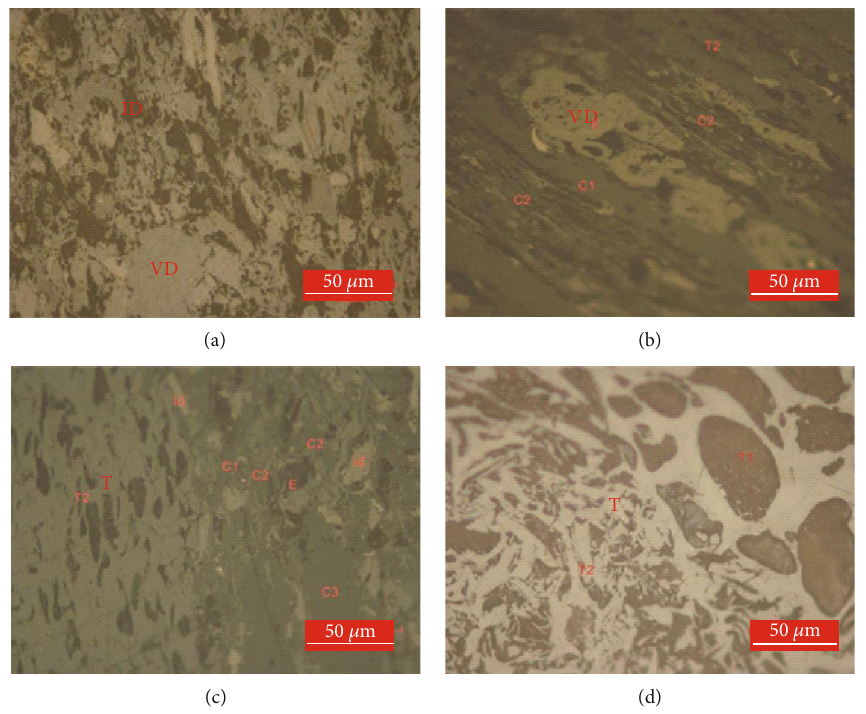
Figure 2: Photomicrographs of macerals present in the samples (T: telovitrinite; VD: vitrodetrinite; ID: inertodetrinite). Table 2: Proximate analysis results and vitrinite re fl ectances of the samples. Sample